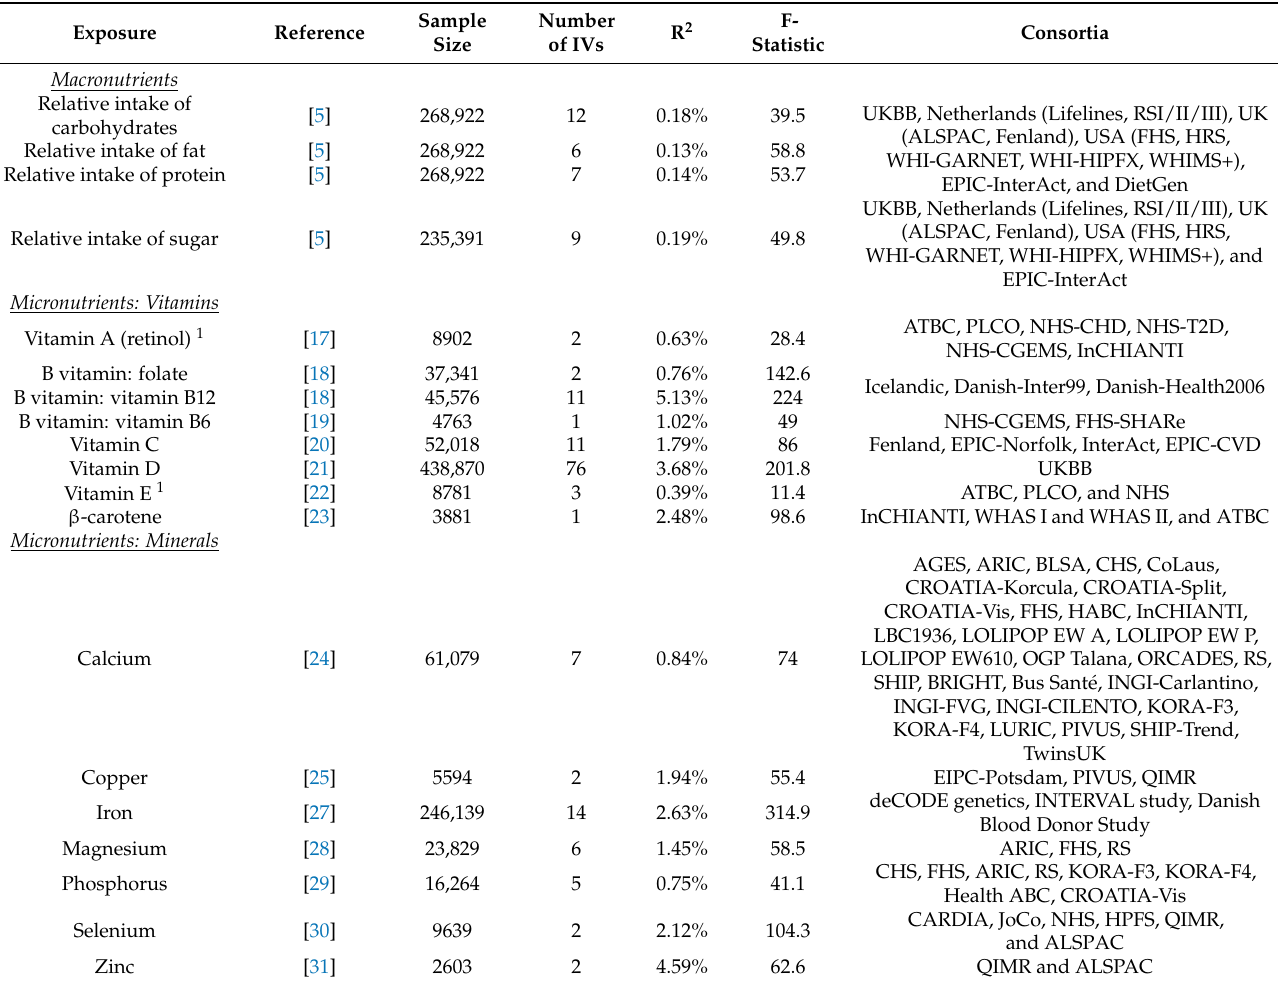
Table 1. Details of genetic instruments for investigated dietary